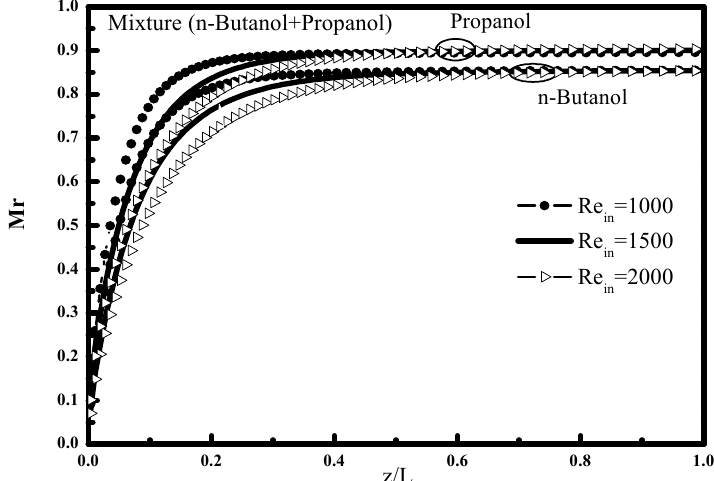
Figure 11. Variation the condensation rate along the tube for different Re in